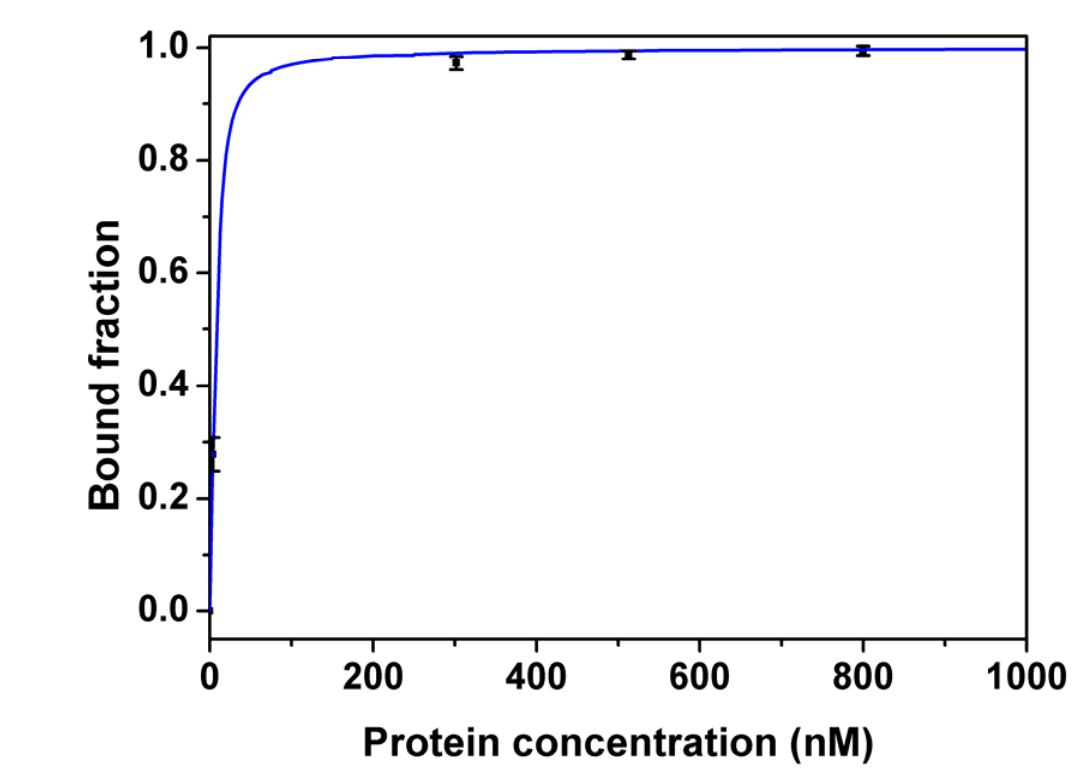
Figure 4. Binding curves of aptamer (Apta1) to lysozyme measured by fluorescence anisotropy. 60 µL of 20 nM ssDNA was incubated with the same volume of different concentrations of lysozyme (0, 3.8, 302, 513 and 800 nM) in quartz cuvettes. The ) was estimated using non-linear least-squares regression analysis. dissociation constant ( K d Full line represents the fitted data and symbols represent the measured data given as averages of three measurements. Error bars indicate the 95% confidence